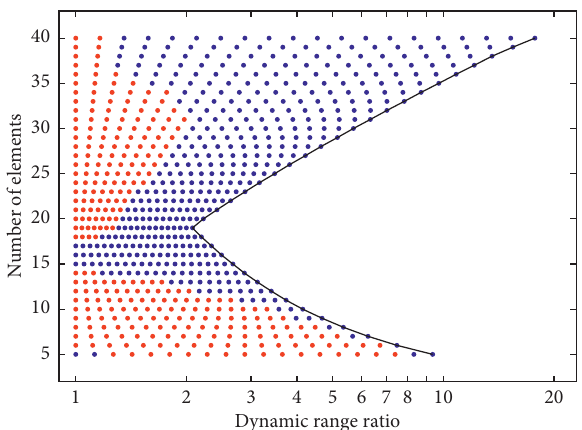
Figure 5: Distribution of all-positive (blue) as well as positive-and- negative (red) coefcients in pencil beam arrays with various numbers of elements and beamwidth of 12 ° , obtained by mini- mization of SLL and constrained DRR. Black curve indicates maximum DRR, which is achieved in DRR-unconstrained design.